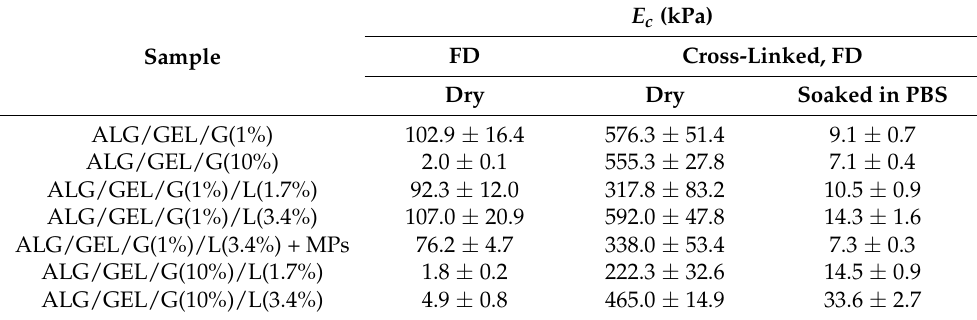
Table 3. The values of compressive modulus ( E c ) of freeze-dried (FD) and cross-linked and freeze- dried matrices based on sodium alginate and gelatin with different amounts of glycerol and lipids, as well as the sample with incorporated PLA microparticles measured under different conditions (dried and after immersion in PBS buffer). E c (kPa) FD Cross-Linked, FD Sample Dry Dry Soaked in